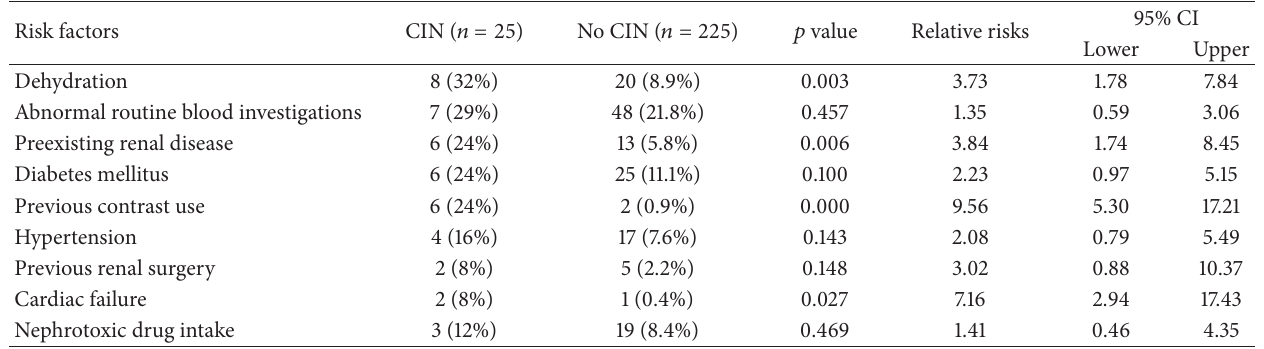
Table 2: Distribution of clinical risk factors between “CIN” group and “No CIN” group.